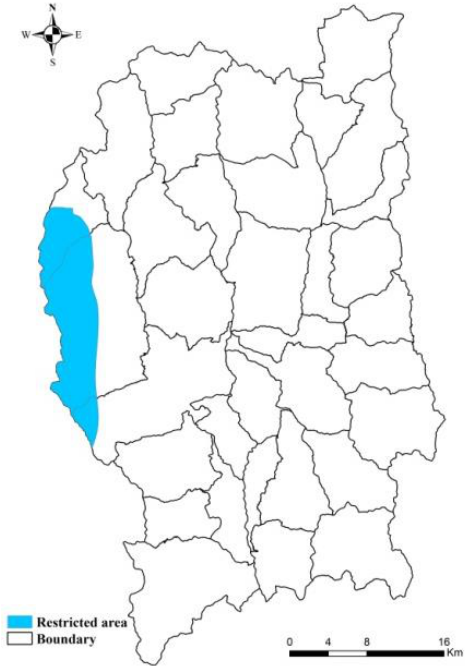
Figure 6. Ecological sensitivity in 2010. Figure 7. Restricted area of Puge County.